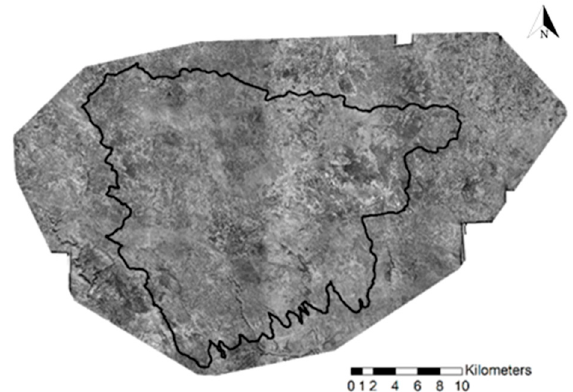
Figure 6. Orthomosaic generated by 67 historical aerial photographs (1954–1955). The black line indicates the study area.